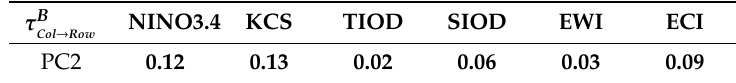
Table 10. IF τ B values between PC2 and the SST-indices based predictors (bold font indicates Col → Row statistically significant values at the 5% level).